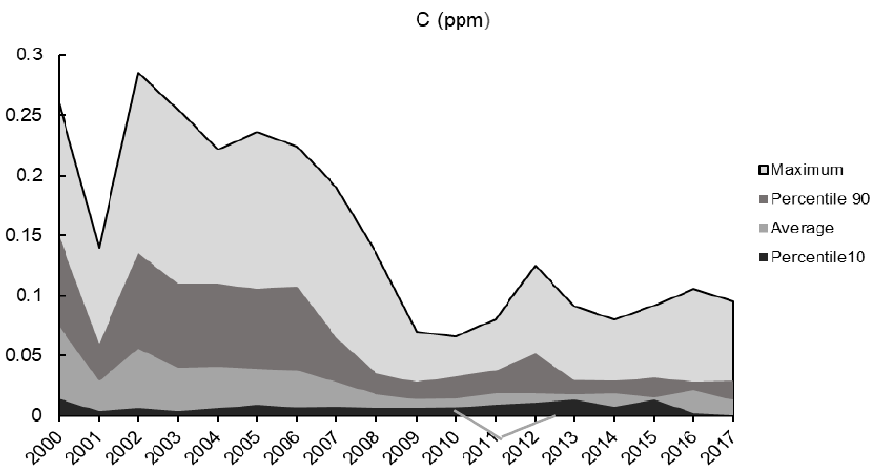
Figure 1. Emissions of SO 2 in Salamanca 2000–2017. Source: Adapted from INECC [18]. Note: Upper light gray indicates the maximum level of SO 2 emission, dark gray shows the percentile 90th; the band gray below shows the average and finally the dark band indicates the 10th percentile of emissions registered by the red cross station during the signal period.